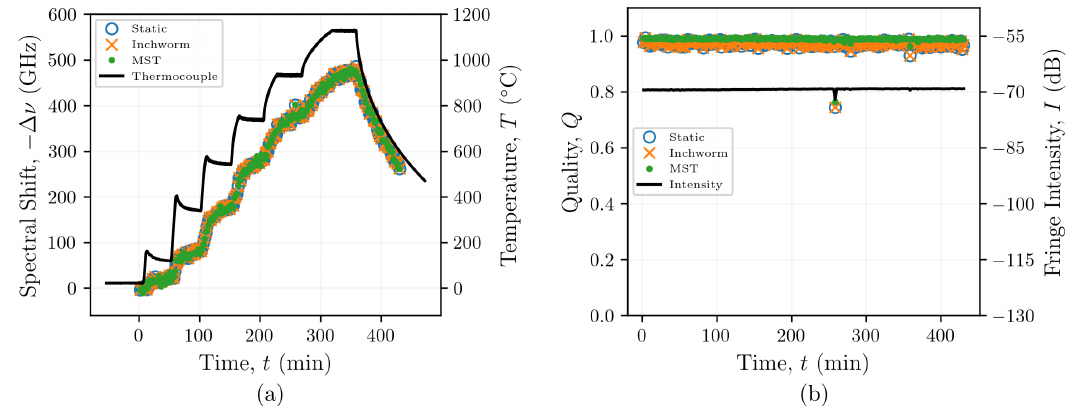
Figure A2. Spectral shifts ( a ) and qualities ( b ) of reconstructions of data from the region of the FBG fiber optical fiber outside of the furnace produced using the static reference, the inchworm algorithm, and MST post-processing methods. The temperatures indicated by the black line are indicative of the furnace temperature at the time of recording and are the cause for the smaller spectral shifts, relative to Figure